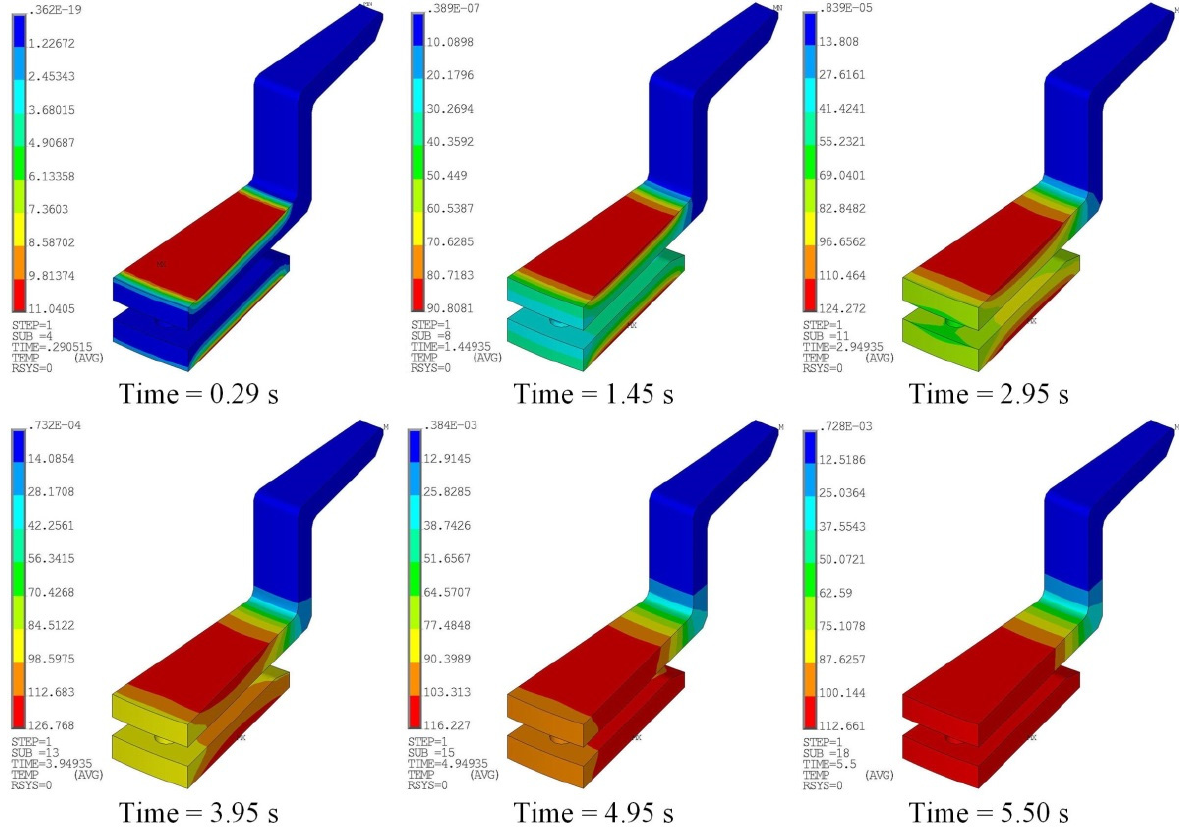
Figure 14. Temperature distributions of the sliced baseline model at various time steps.